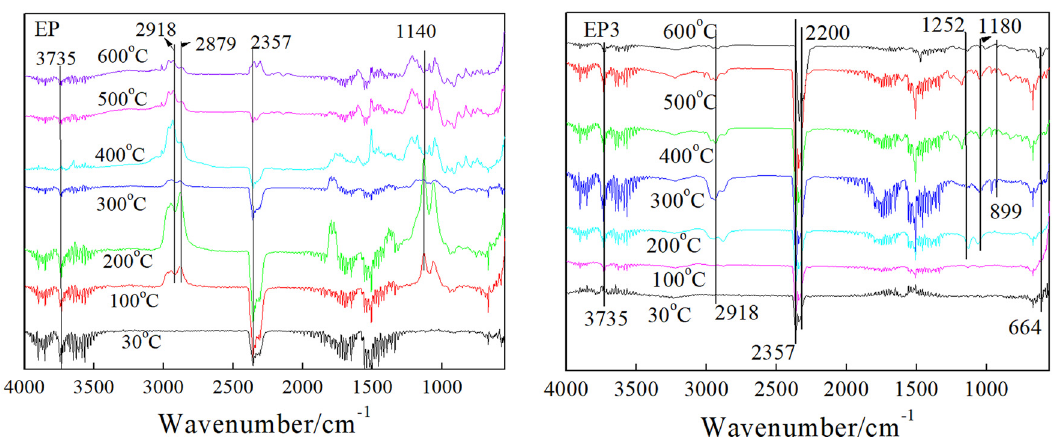
Figure 11: TG – IR curves of pure EP and